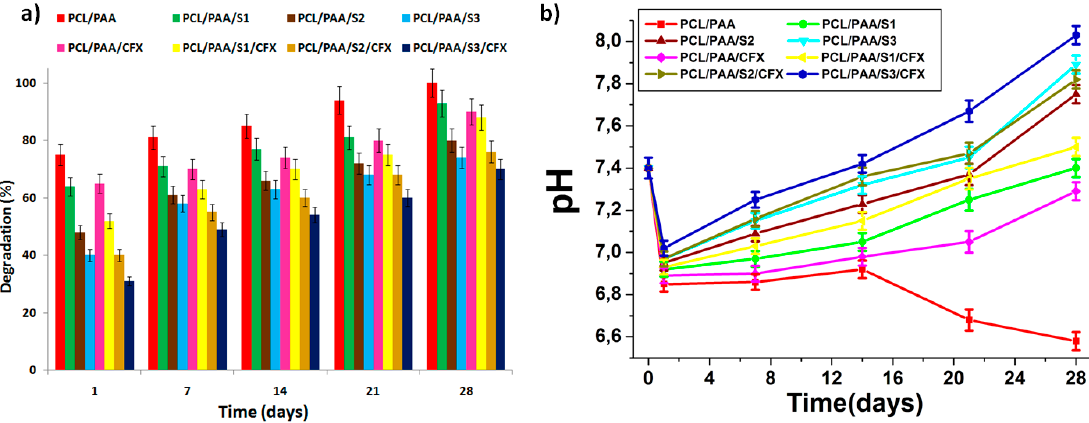
Figure 6. ( a ) Biodegradation (%) and ( b ) SBF pH variations for all the prepared scaffolds after different interval times of immersion in SBF. interval times of immersion in